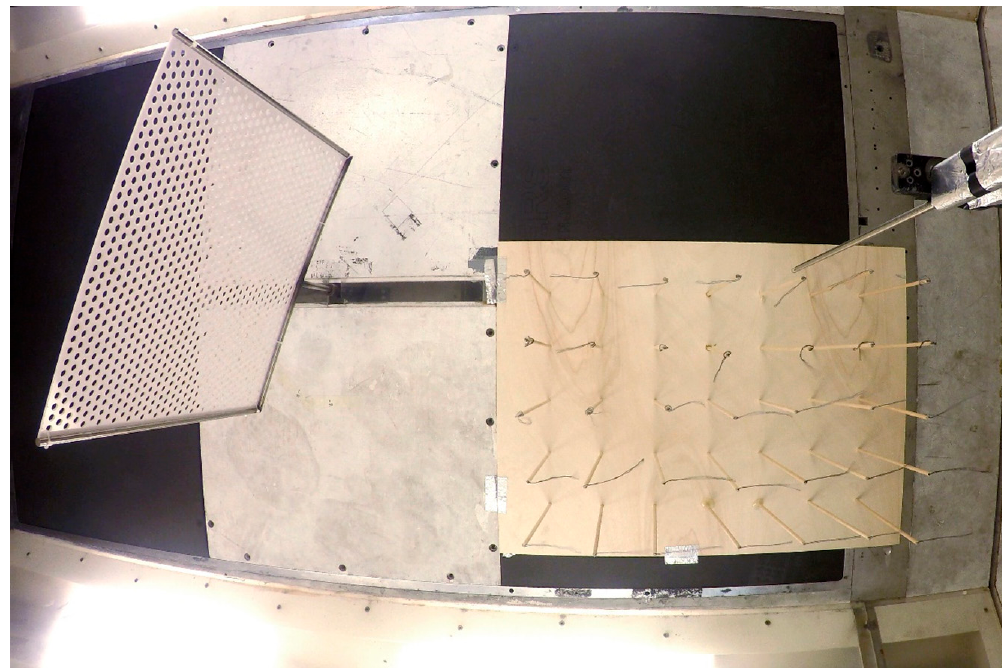
Figure 23. Perforated board (acrylic) 70° 12.3 m/s. A vortex has taken shape behind the model.